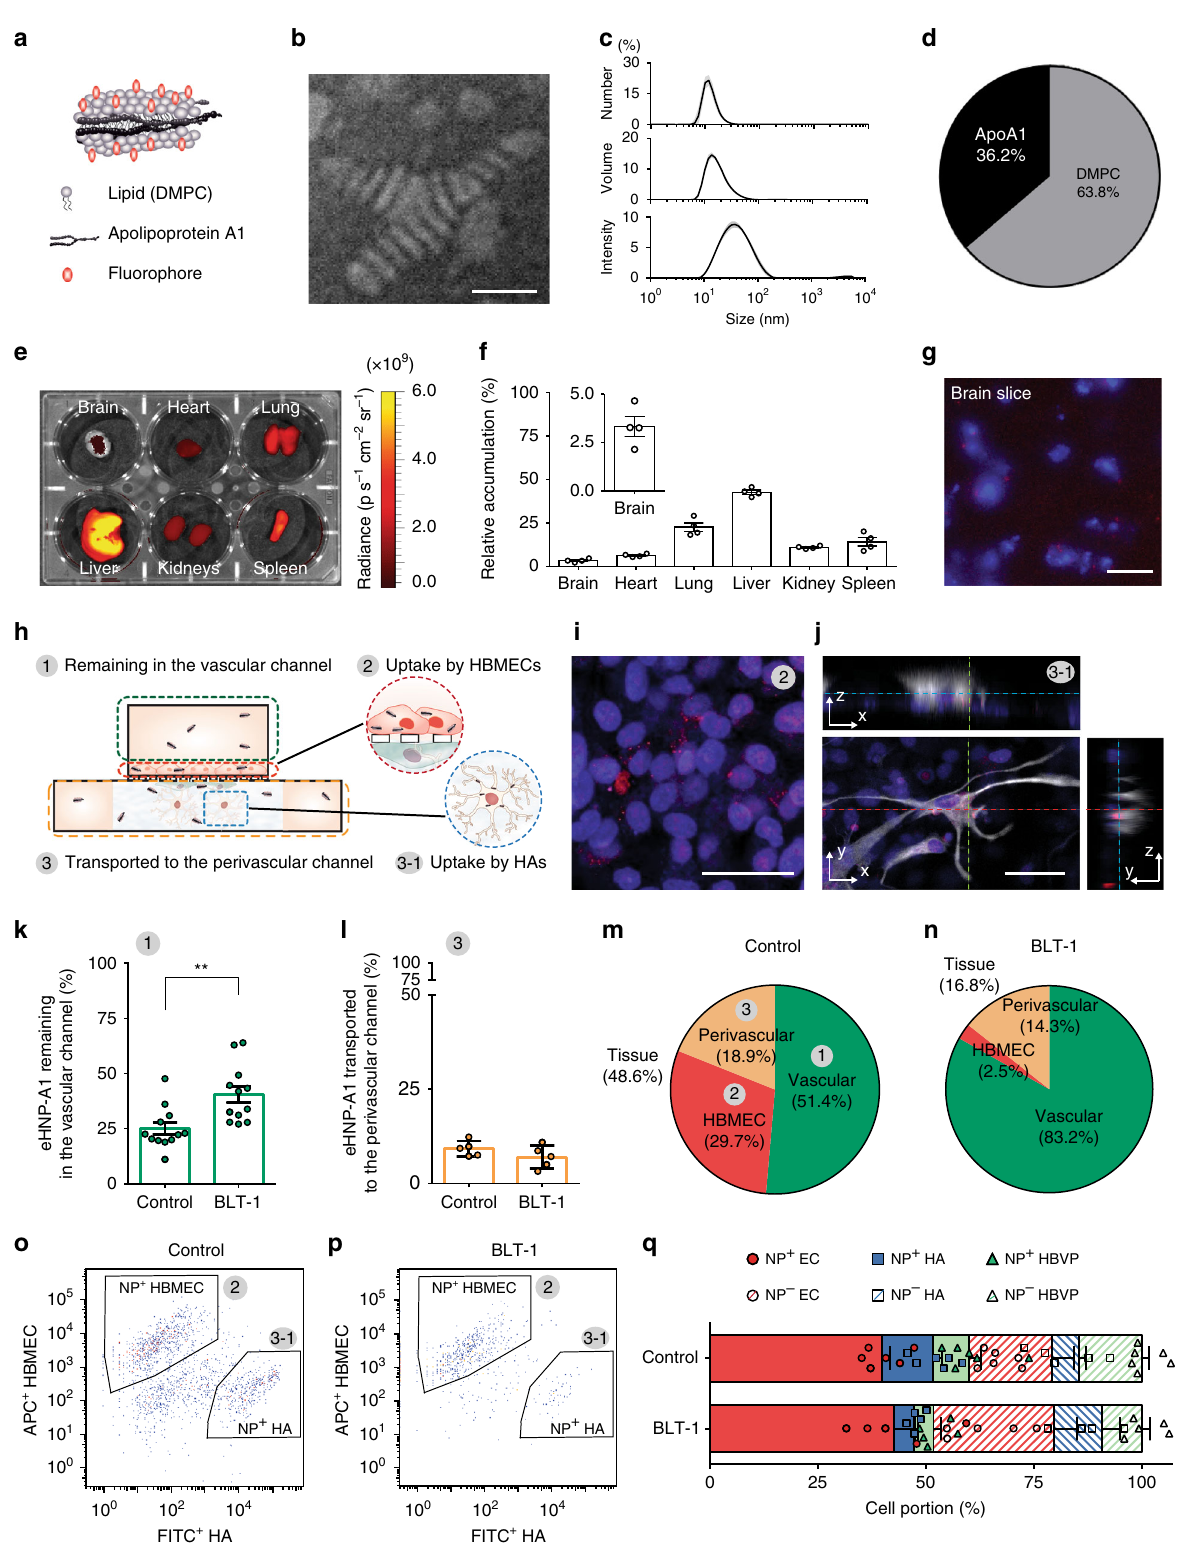
inde fi nite proliferation while preserving their properties.